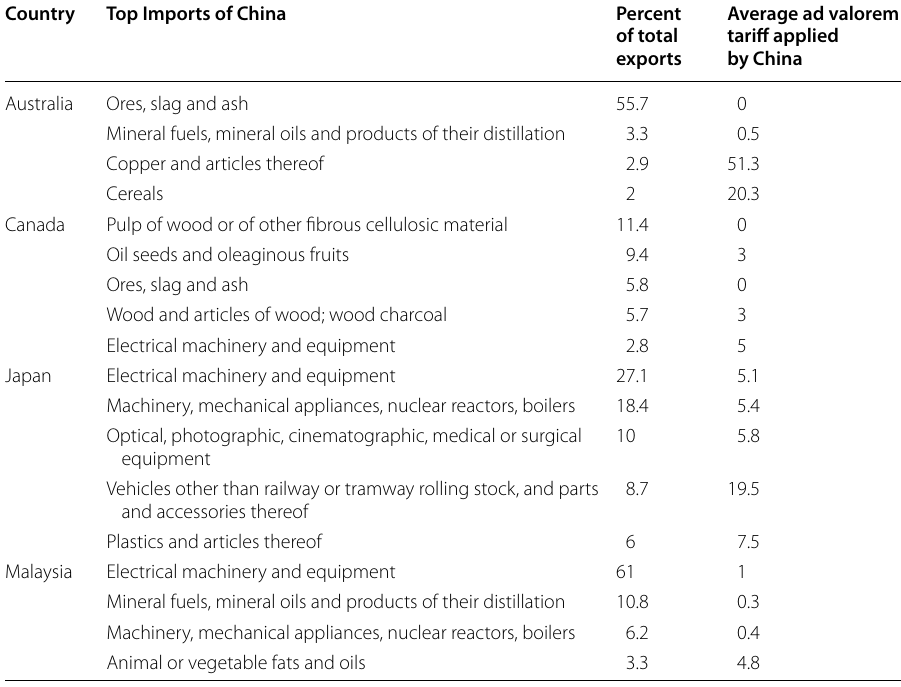
Table 5 China’s top imports from its top import sources in TPP region (2015). Source : Trade Map (available at